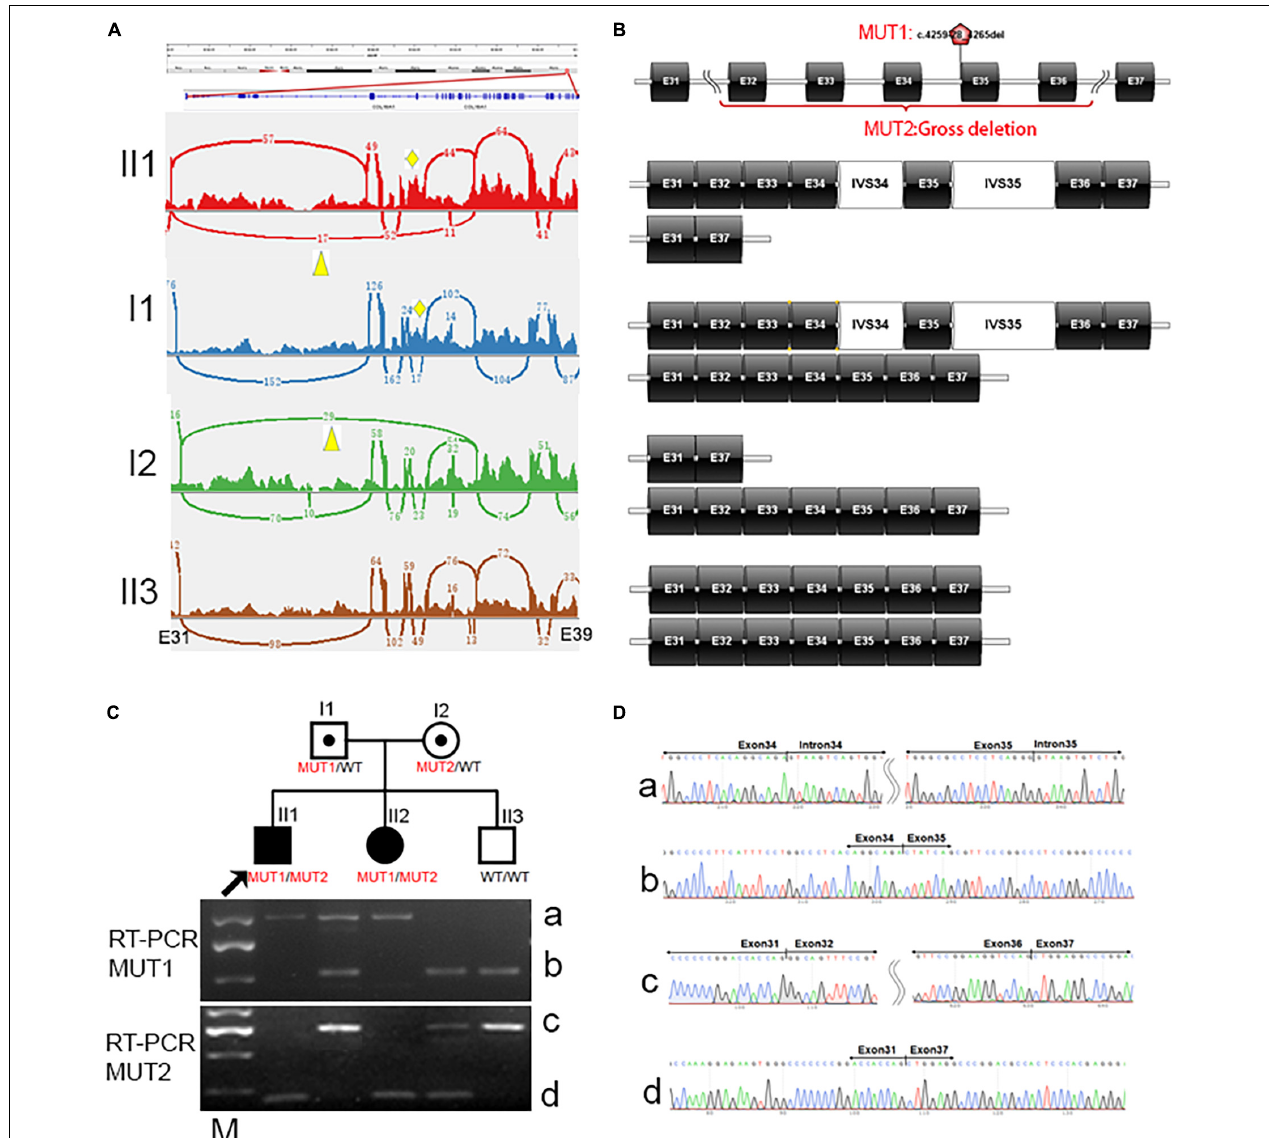
FIGURE 4 | Identification of biallelic mutants for COL18A1 in family 14518 by RNA sequencing. (A) Splicing-in of the pseudoexon, IVS34 and IVS35, is observed in proband II1 and his father I1, indicated by a yellow rhombus. Gross deletion crossing Exon 32 to exon 36 is observed in proband II1 and his mother, indicated by a yellow triangle. (B) Schematic diagram of four different kinds of transcript way between Exon 37 to exon 37 of COL18A1 in proband, carriers, and normal of different genotypes. (C) The biallelic mutants is observed in RT-PCR amplicons from family 14518. MUT1: Compare with wildtype of band b with 525bp in II3, the aberrant band a is longer (1010 bp) due to splicing-in of the IVS34 and IVS35 (485 bp). MUT2: Compare with wildtype of band c with 724 bp covering exon 31-37 in II3, the aberrant band d is shorter (192 bp) caused by deletion of exon 32 to 36 (532 bp). (D) The aberrant bands are confirmed by Sanger sequencing. M: DL2000 DNA Marker with a brighter fragment at 750